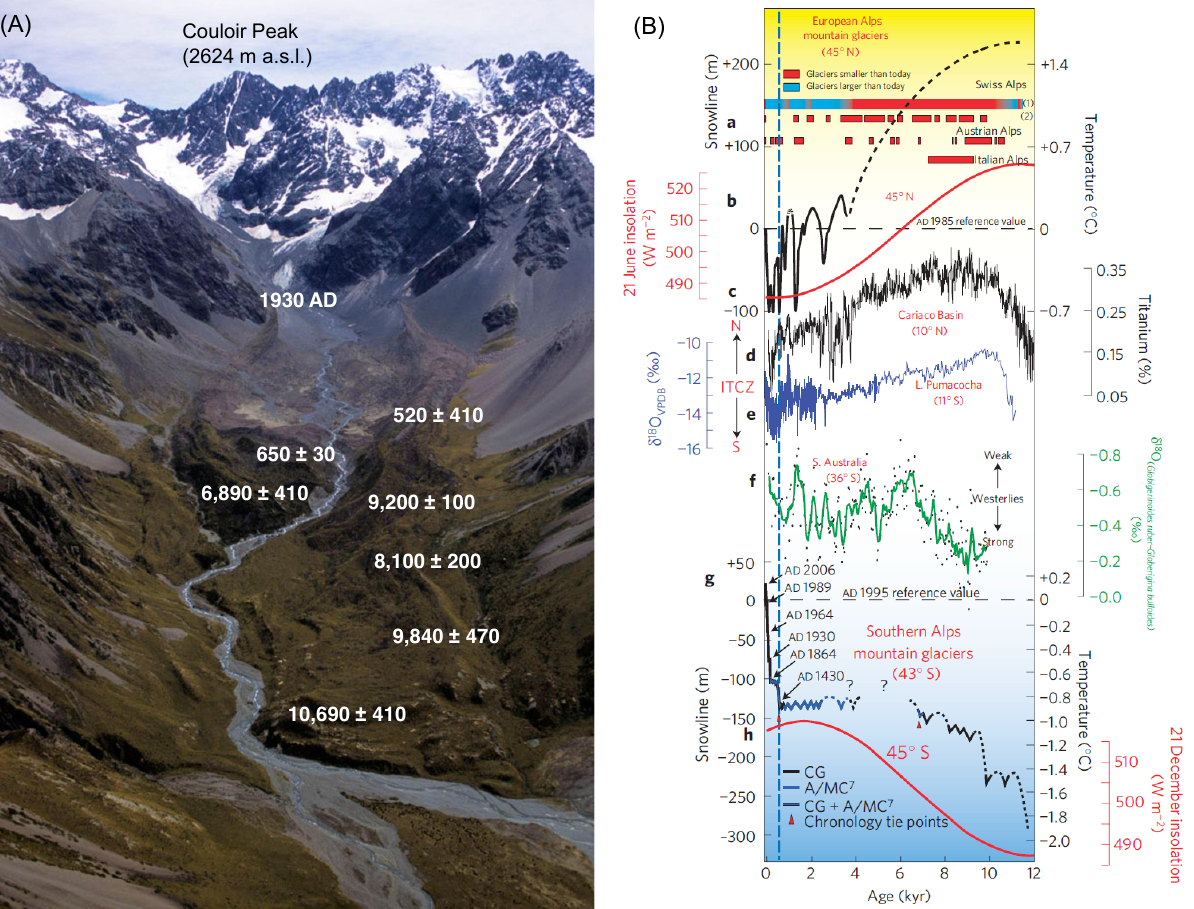
Figure 9. In Fig 9A the mean 10 Be ages in years (uncertainties 1σ) resulting from the work of Putnam et al . [18] are displayed at the Holocene moraines from the Cameron glacier. The oldest age signals the largest glacier advance at the Early Holocene. Fig. 9B shows an interesting comparison of various temperatures proxies for the NH (panels a-e) and the SH (panels f-h). For a detailed description of Fig. 9B, see Ref.